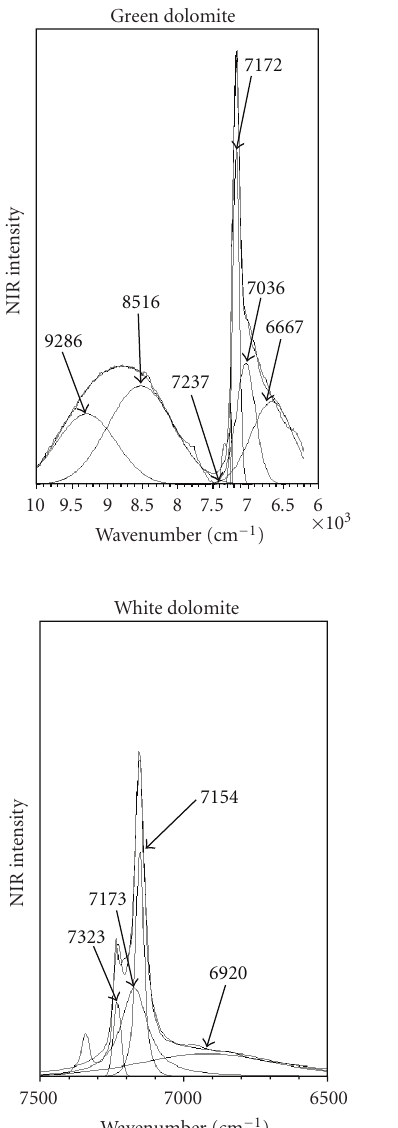
Figure 6: NIR spectrum of dolomite at room temperature from 5500–4000 cm − 1